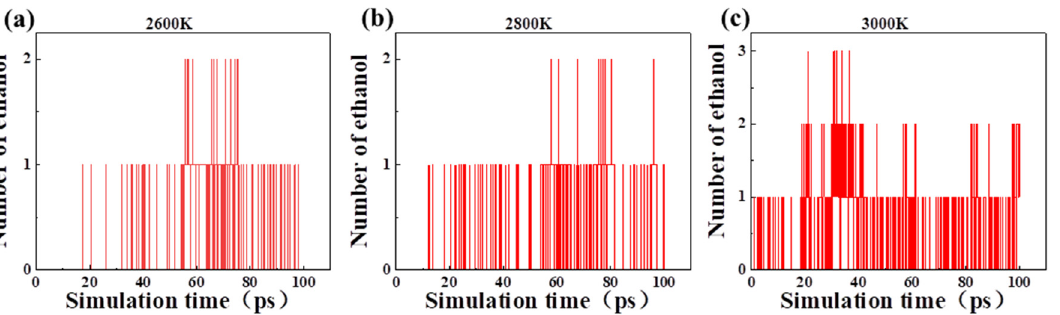
Figure 9. Production of ethanol molecule in the pyrolysis of LGA at different temperatures: ( a ) 2600 K; ( b ) 2800 K and ( c ) 3000 K.